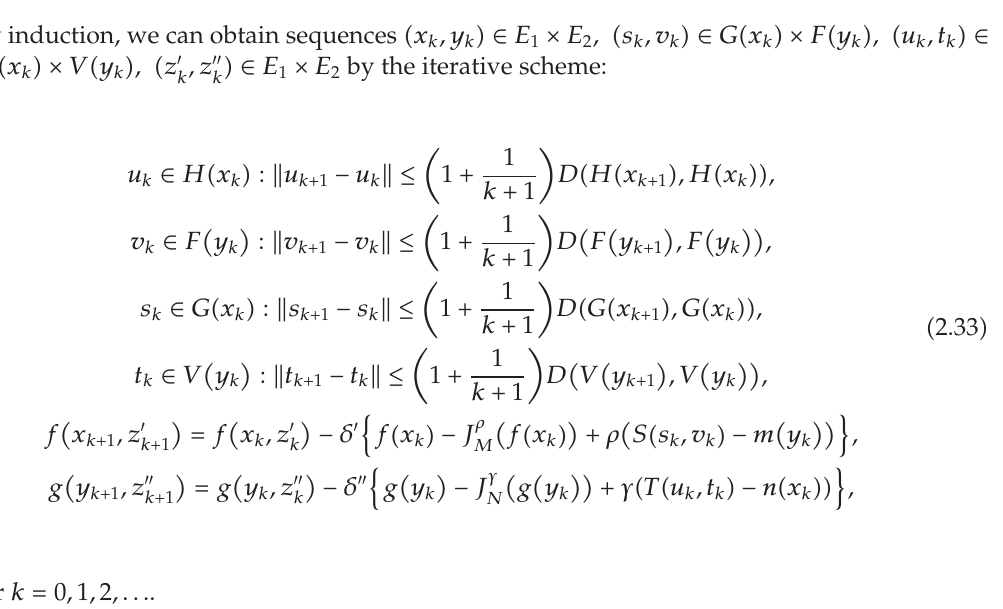
Algorithm 2.6. For given (cid:2) x 0 , y 0 (cid:3) ∈ E 1 × E 2 , (cid:2) s 0 , v 0 (cid:3) ∈ G (cid:2) x 0 (cid:3) × F (cid:2) y 0 (cid:3) , (cid:2) u 0 , t 0 (cid:3) ∈ H (cid:2) x 0 (cid:3) × V (cid:2) y 0 (cid:3)